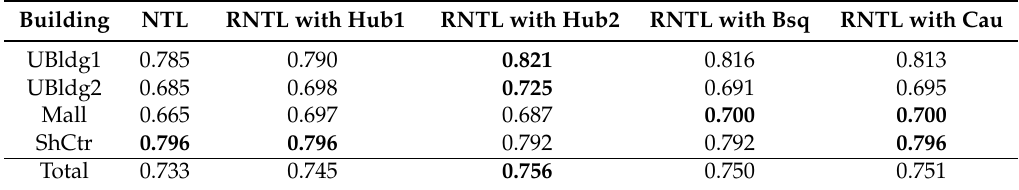
Table 5. Comparison of the floor detection probabilities for nonlinear trilateration approach (NTL) and four robust NTL (RNTL) versions of it. All of the robust methods outperform the ordinary nonlinear